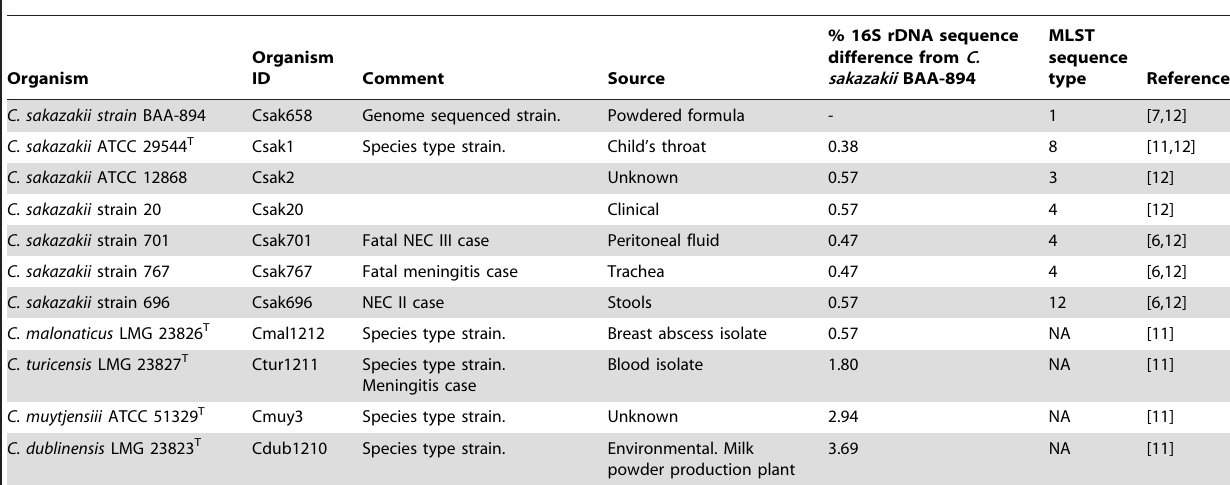
Table 1. Bacterial strains used in this